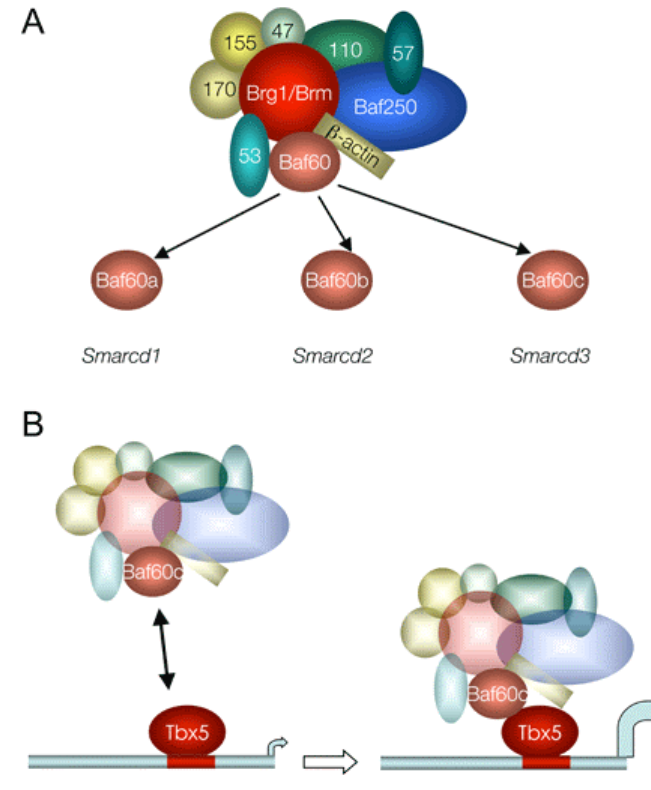
FIGURE 1. (A) The BAF complex. Baf60a–c are shown as examples of polymorphic subunits, with their gene name ( Smarcd1–3 ); (B) model for recruitment of the BAF complex by Tbx5 via interactions with